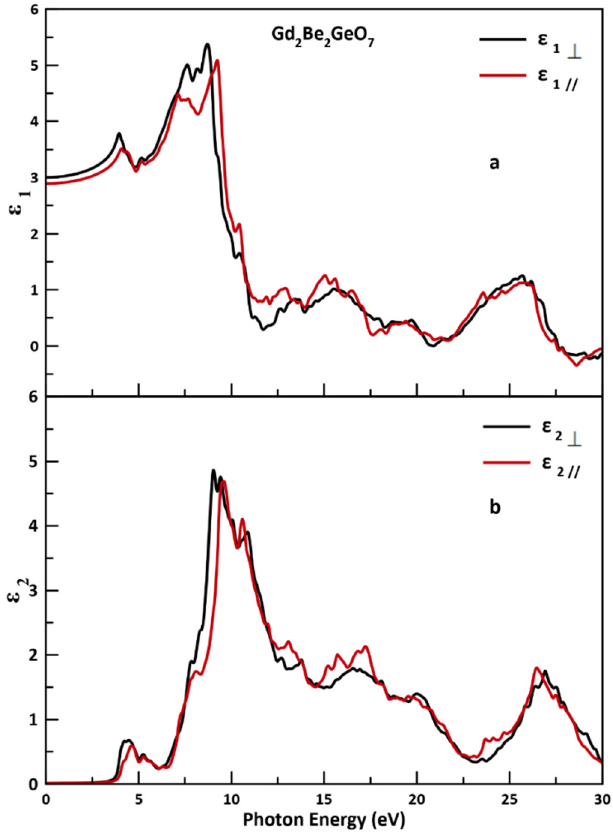
Figure 7. ( a ) The real part and ( b ) imaginary parts of the dielectric function in both parallel and perpendicular directions for Gd 2 Be 2 GeO 7 compound.